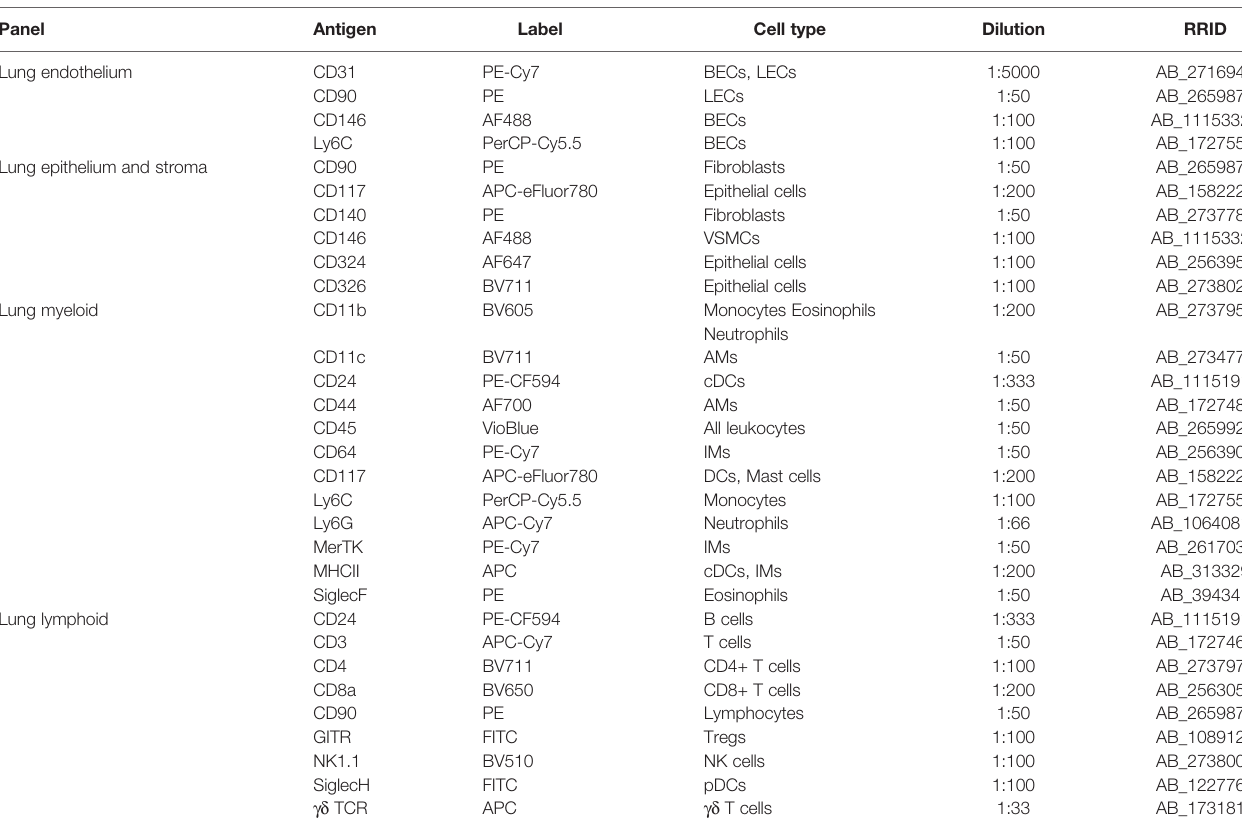
Antibodies, and respective fl uorochromes, that were used for identi fi cation of lung cell populations by FACS analysis. AMs, Alveolar macrophages; BECs, Blood endothelial cells; cDCs, Conventional dendritic cells; IMs, Interstitial macrophages; LECs, Lymphatic endothelial cells; NK, Natural killer; pDCs, Plasmacytoid dendritic cells; Tregs, Regulatory T cells; VSMCs, Vascular smooth muscle